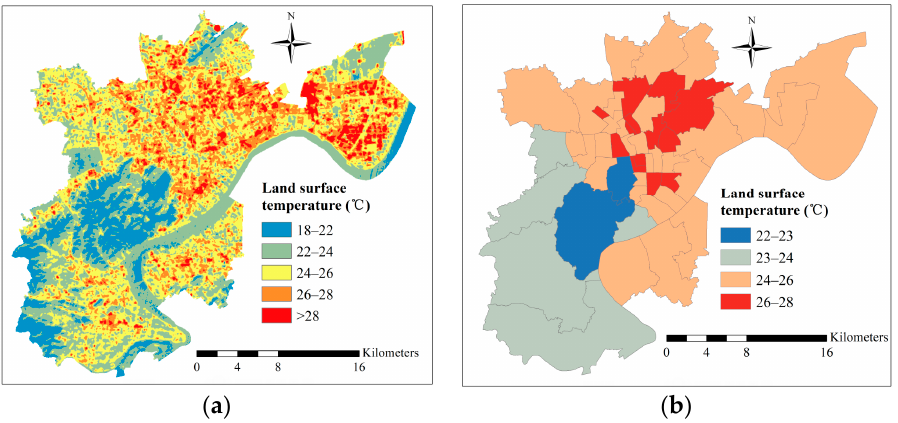
Figure 4. Land surface temperature retrieved from the Landsat 8 image: ( a ) inversion result with 30 m spatial resolution, and ( b ) average surface temperature for street-town unit.